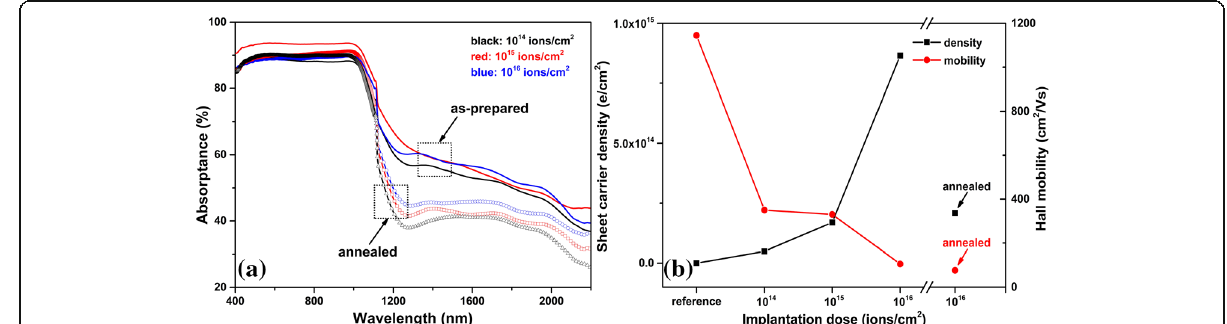
Fig. 2 a Dependence of absorptance on different ion-implantation dose. All samples were microstructured by PLM. b Electronic properties of reference silicon and microstructured silicon for different ion-implantation dose before annealing and one after annealing